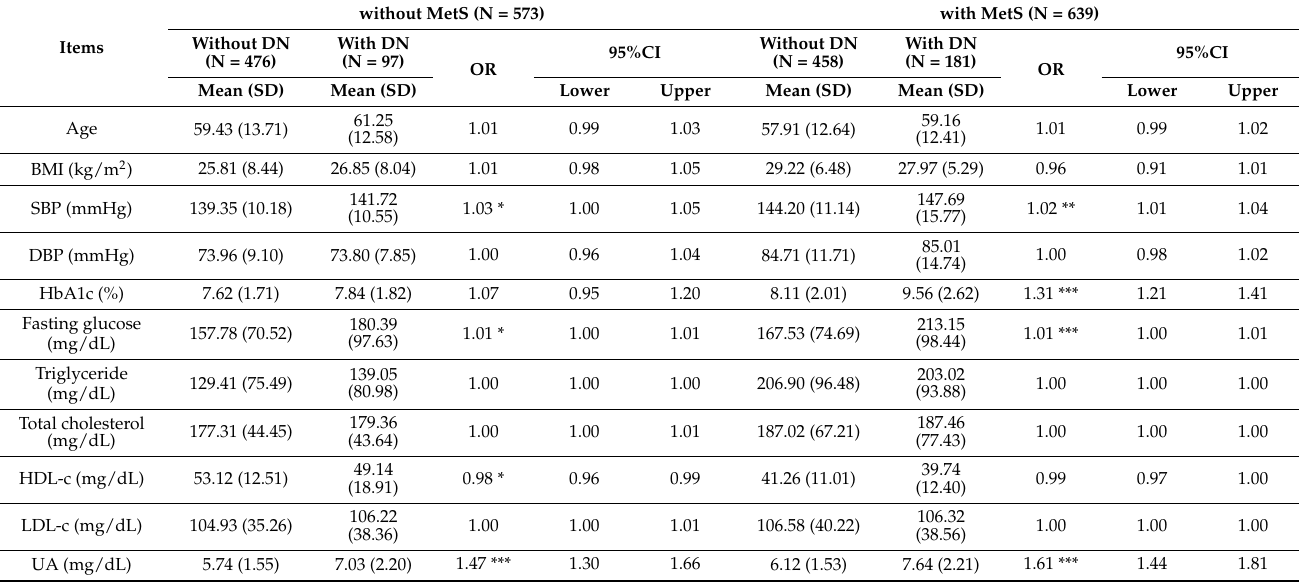
Table 3. Comparisons of continuous factors of DN between patients with and without MetS (N =